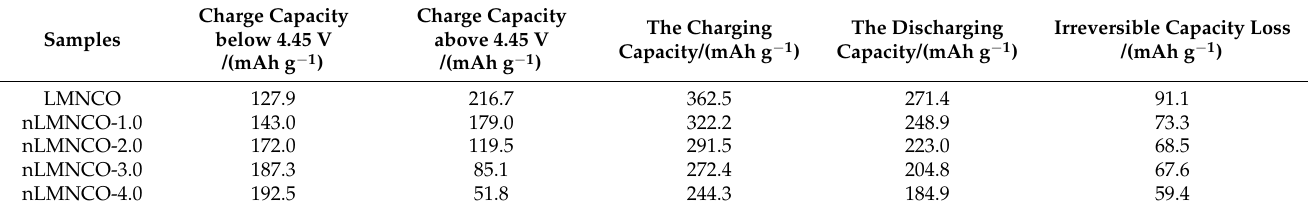
Table 2. The charge-discharge capacity performance of the cathode material in the initial cycle.